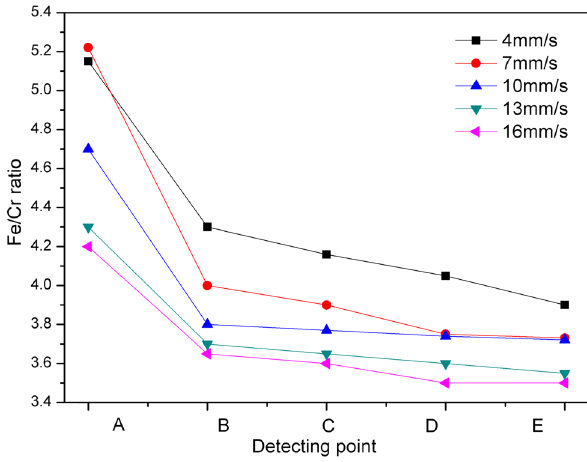
Figure 6: Fe/Cr ratio for di ff erent sampling areas in cladding